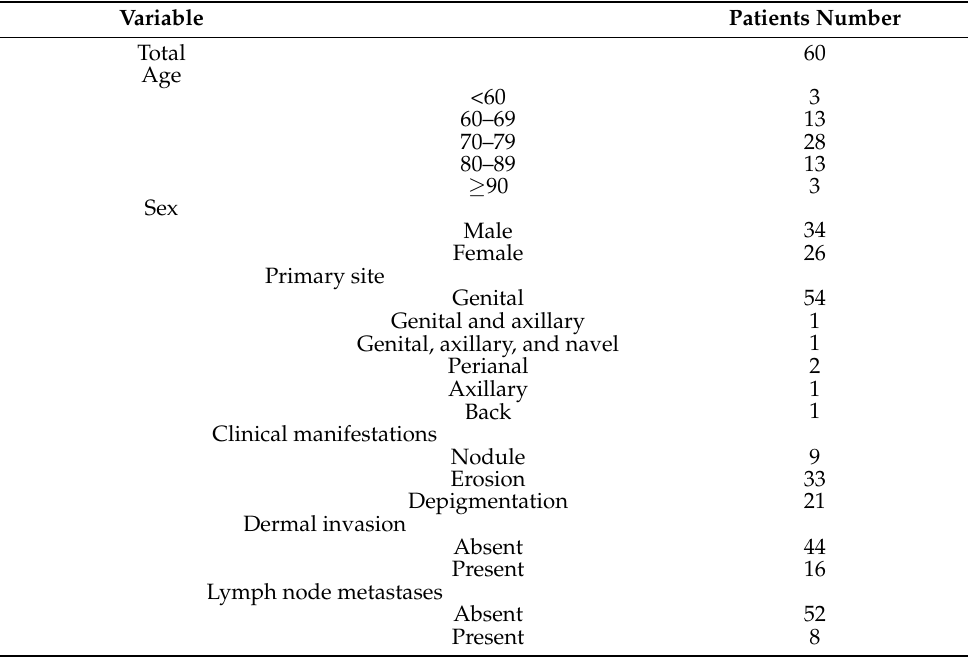
Table 1. Clinical characteristics of extramammary Paget’s disease patients in this study.